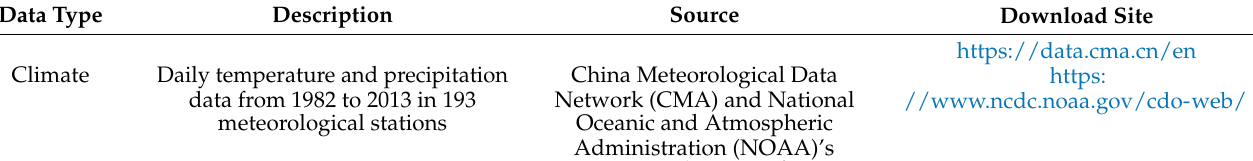
Table 2. Datasets used in this study as representative of environmental factors. Data